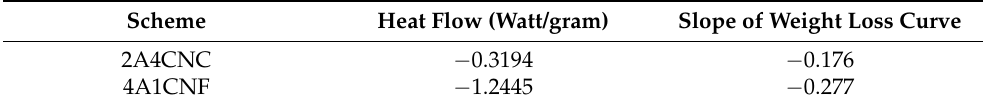
Table 1. Thermal characterization results at body temperature of 37 ◦ C. (2A4CNC: 2% Alginate and 4% Cellulose Nanocrystals, 4A1CNF: 4% Alginate and 1% Cellulose Nanofiber). Scheme Heat Flow (Watt/gram) Slope of Weight Loss Curve 2A4CNC − 0.3194 − 0.176 4A1CNF − 1.2445 −